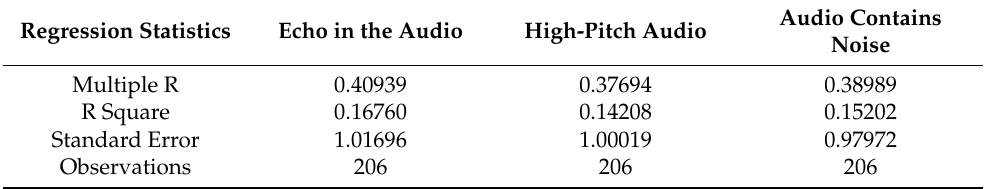
Table 4. The summary output for the audio group of degradations.